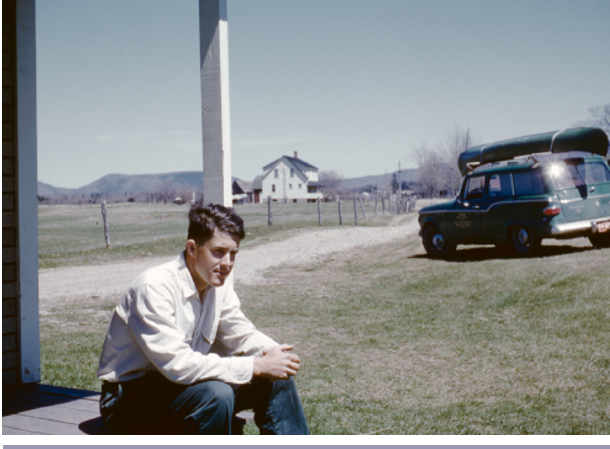
Fig. 1 . Anthony (Tony) Erskine, Margaree, NS. Photo courtesy of Anthony